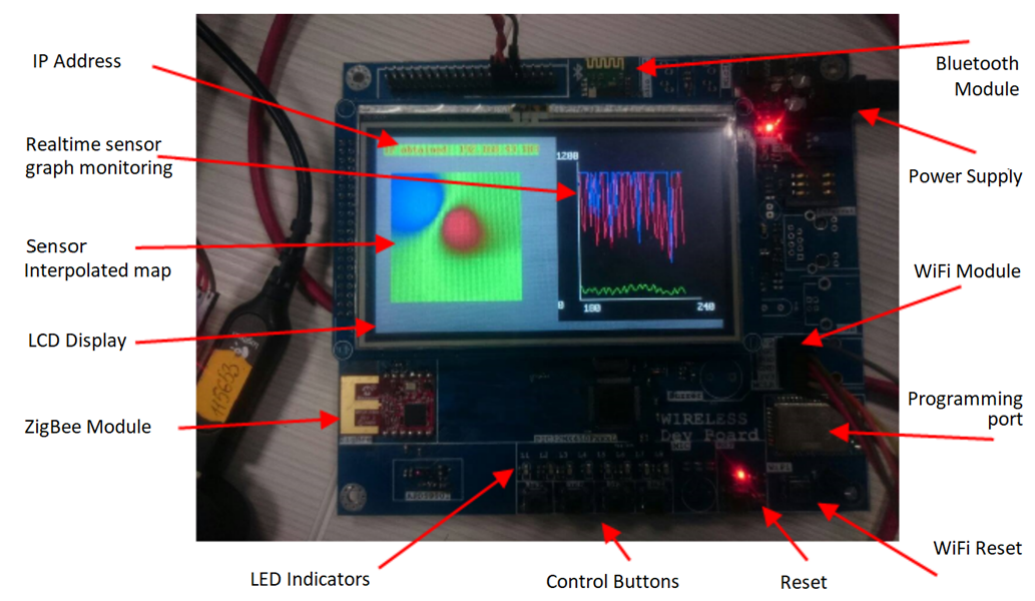
Figure 13. IoT server prototype for snvironmental data